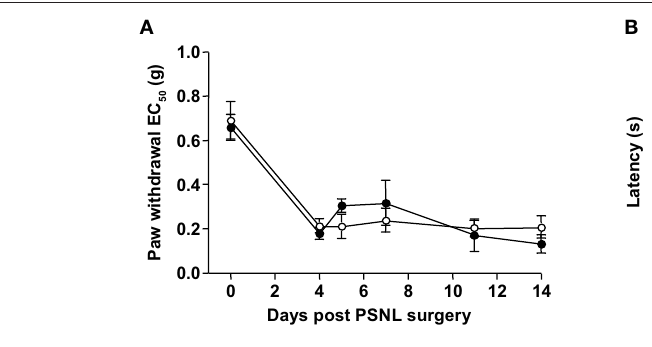
FIGURE 5 | Glra3 − / − mice show no differences in behavioural hypersensitivitiy following experimentally induced peripheral neuropathy. (A) Signifi cant mechanical hypersensitivity was observed in Glra3 − / − mice at days 3, 5, 7 and 14 ( p < 0.01– p < 0.001) and wild-type mice at days 3–14 ( p < 0.05– p < 0.01) following surgery compared with contralateral controls ( n = 6).